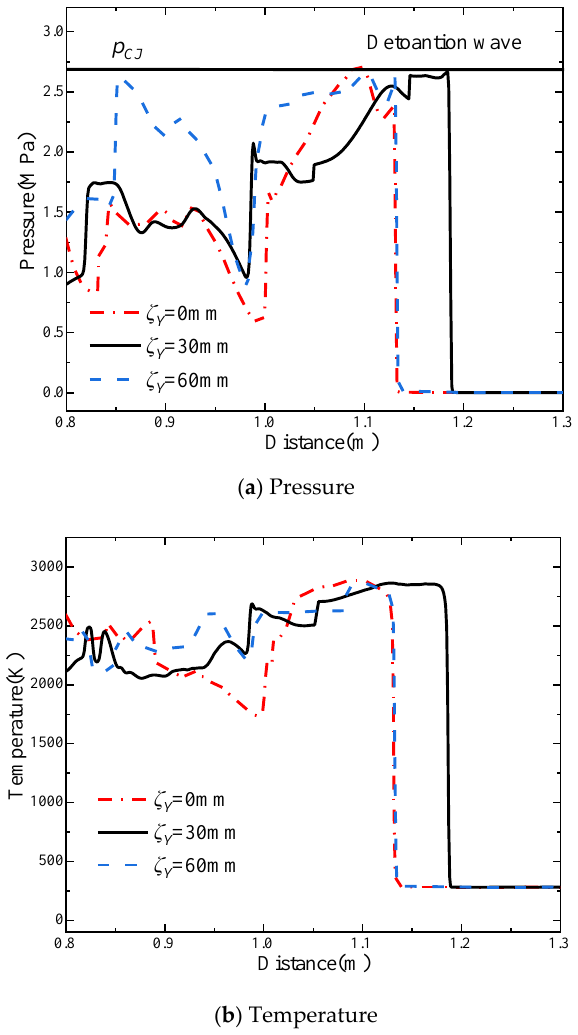
Figure 18. Distributions of ( a ) pressure and ( b ) temperature of ζ Y ≤ 60 mm at t TDC = 1.44 ms. Base on Figure 19, the propagation distance of pressure wave and flame decrease as ζ Y increasing, and the pressure wave propagate slightly further than flame front. It is clearly seen that the pressure of deflagration wave is weak at this time, and value of pressure wave decreases as ζ Y increasing. The pressure of ζ Y = 150 mm is obviously lower than other ignition positions, which does not form the leading shock.